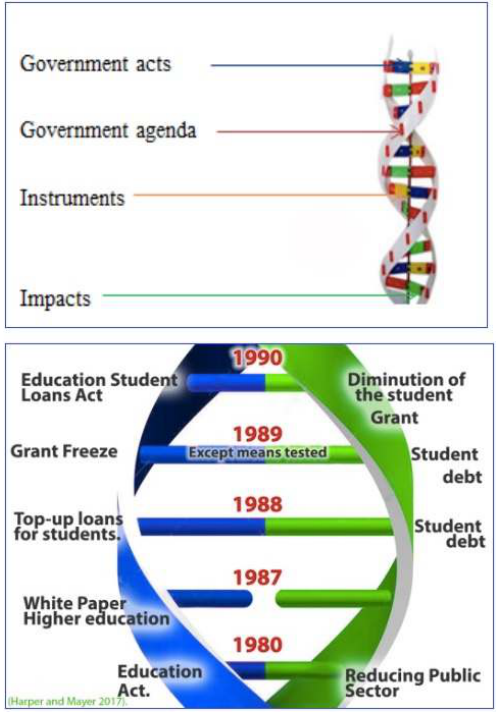
Figure 13. Development of the model in 2D